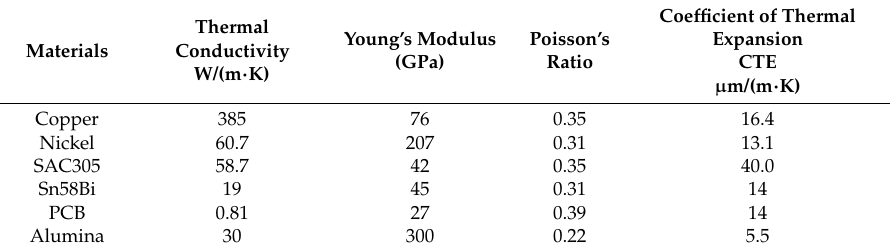
Table 1. Properties of the study